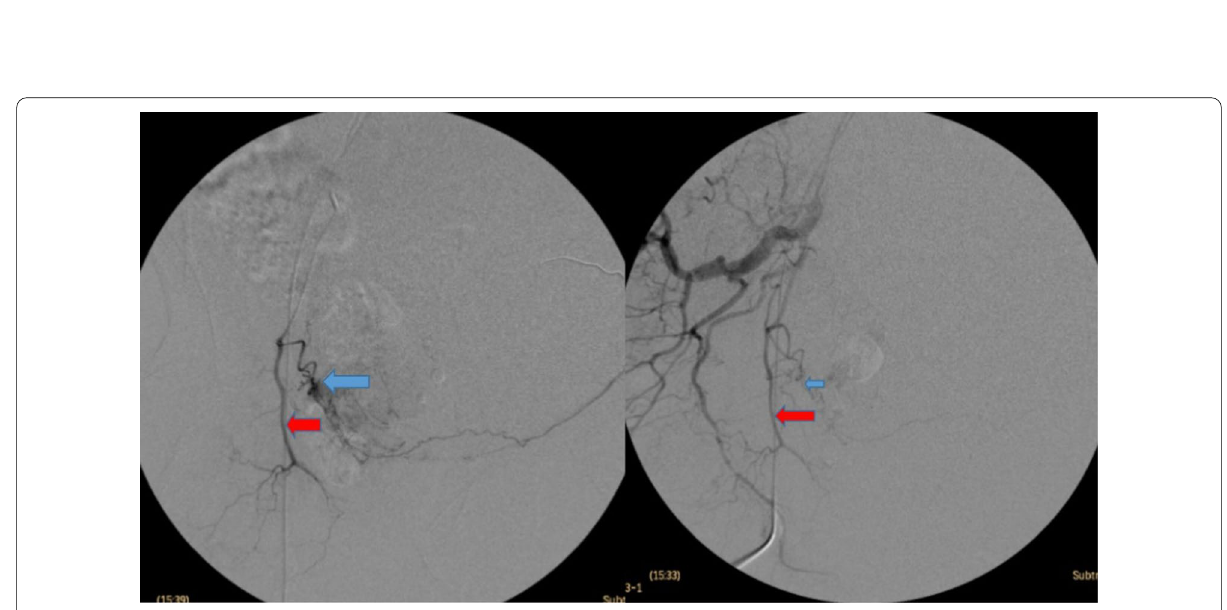
Fig. 10 Angiography images showing the origin of right prostatic artery (blue arrow) from obturator artery (red arrow), from anterior trunk of